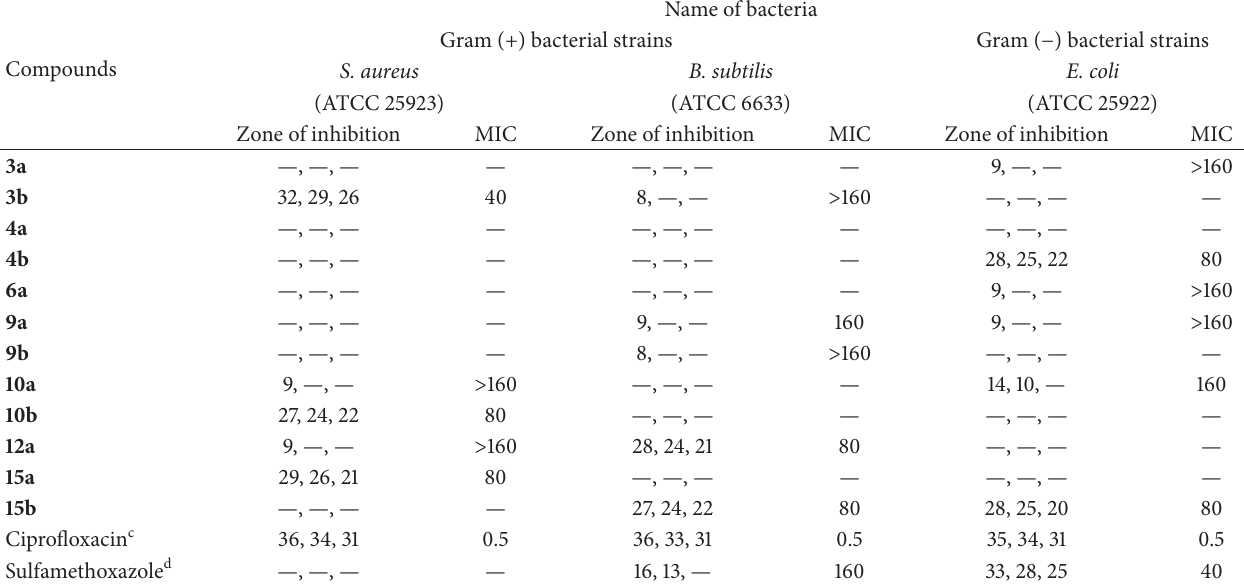
Table 2: Zone a of inhibition and MIC b of sulfonamides against pathogenic bacterial